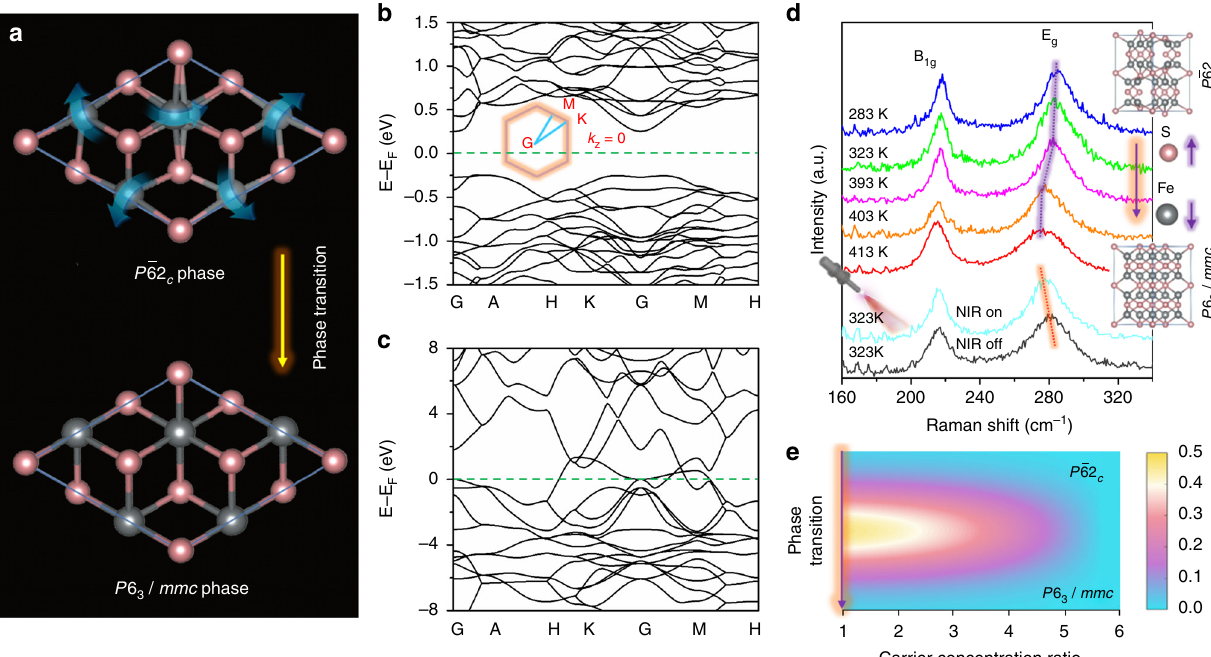
Fig. 2 Phase transition of FeS nanosheets. a Structural transition from distorted P (cid:1) 62 c phase to high-symmetry P 6 3 / mmc phase. The displacement vectors are marked by blue arrows. b The band structure of P (cid:1) 62 c phase. c The band structure of high-symmetry P 6 3 / mmc phase. d In situ Raman spectra as functions of temperature with or without NIR light irradiation. e The potential barrier of phase transition as a function of carrier concentration